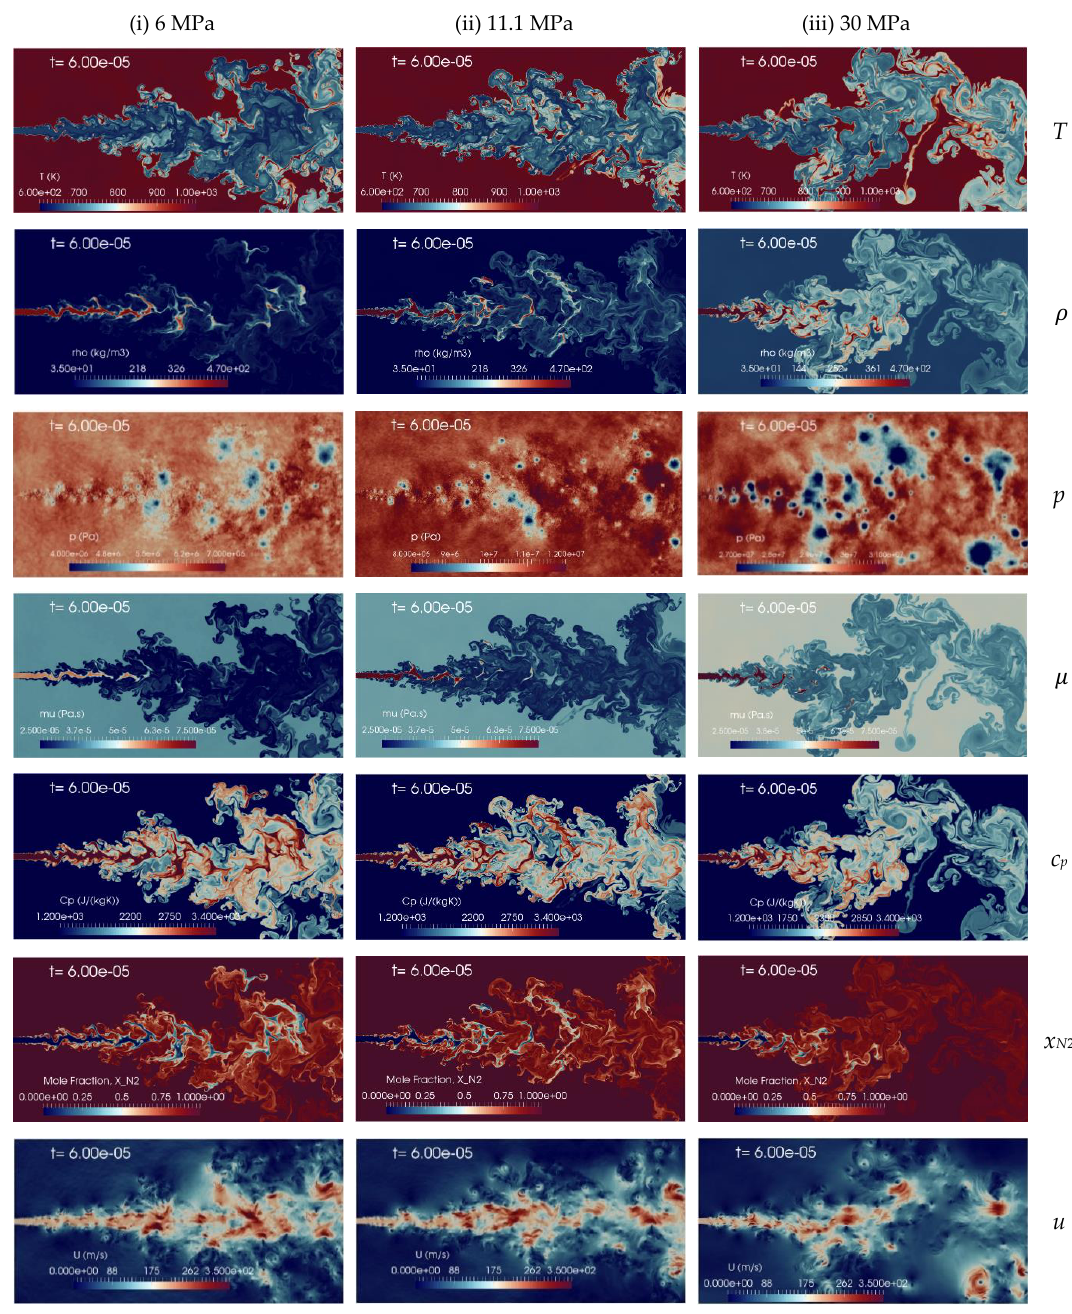
Figure 14. Instantaneous contour plots obtained from simulations of n-dodecane injected at 658.2 K and 200 m/s into nitrogen at 972.9 K, for three different chamber pressures: first column 6 MPa, second column 11.1 MPa, third column 30 MPa. Rows, from top to bottom, show temperature T [K], density 𝜌 [kg/m 3 ], pressure p [Pa], dynamic viscosity 𝜇 [Pa ∙ s ], specific heat at constant pressure c p [J/(kg K)], mole fraction of nitrogen x N 2 [-], and velocity u [m/s].